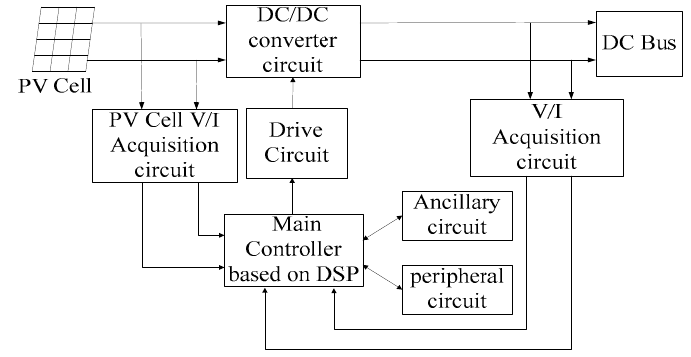
Figure 3. Charging control scheme of the DC-link bus integrated PV cell.